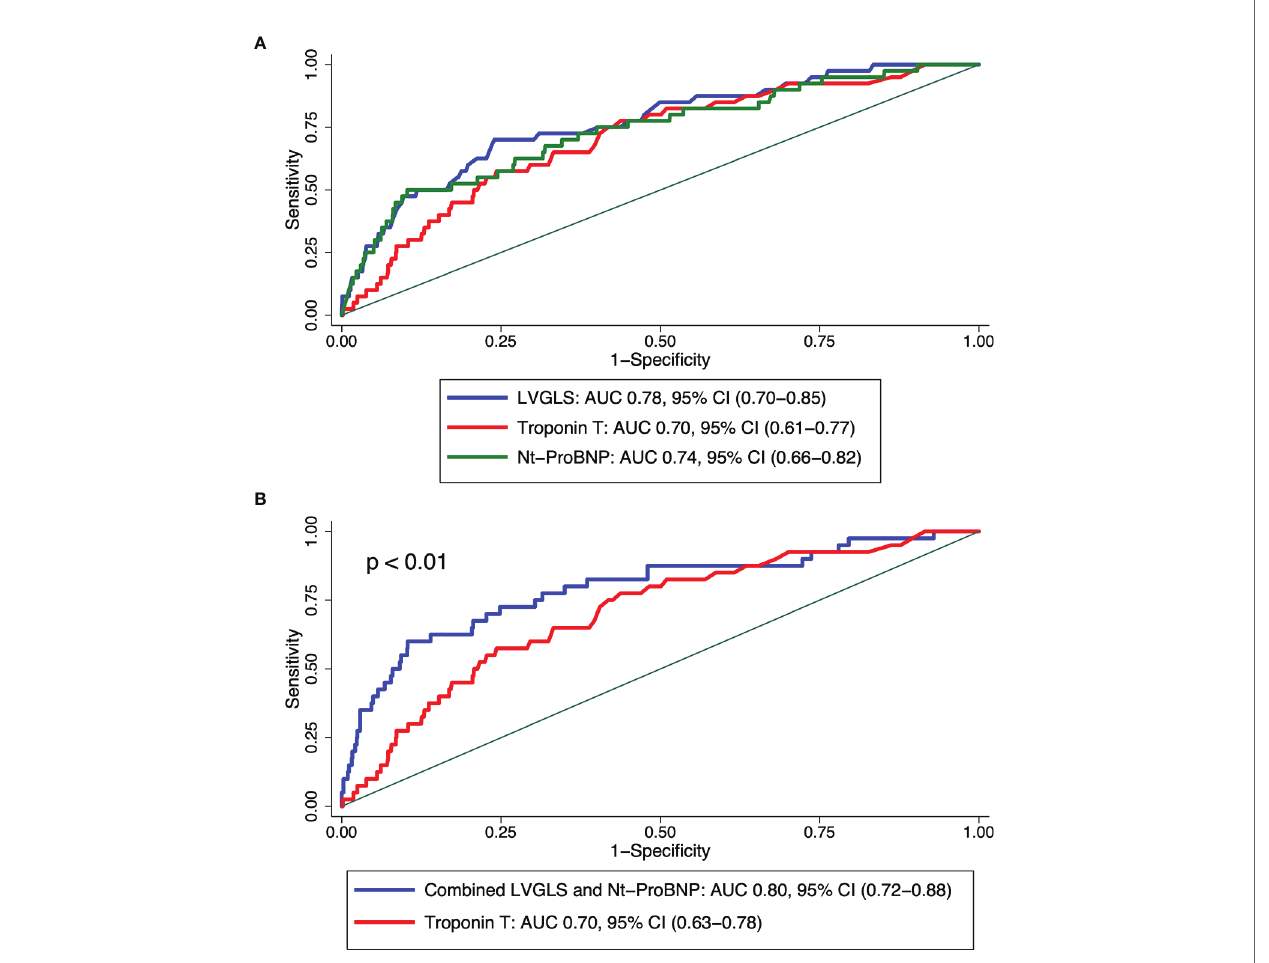
FIGURE 2 | Receiver operating characteristic (ROC) curves demonstrating (A) the ability to predict severe acute rejection ( ≥ 2R) by echocardiographic left ventricular global longitudinal strain (LVGLS) magnitude, plasma NT-ProBNP level, and plasma high-sensitivity troponin T level and (B) the ability to predict severe acute rejection ( ≥ 2R) by combined echocardiographic left ventricular global longitudinal strain (LVGLS) magnitude and plasma NT-ProBNP level versus plasma high- sensitivity Troponin T level to predict ≥ 2R